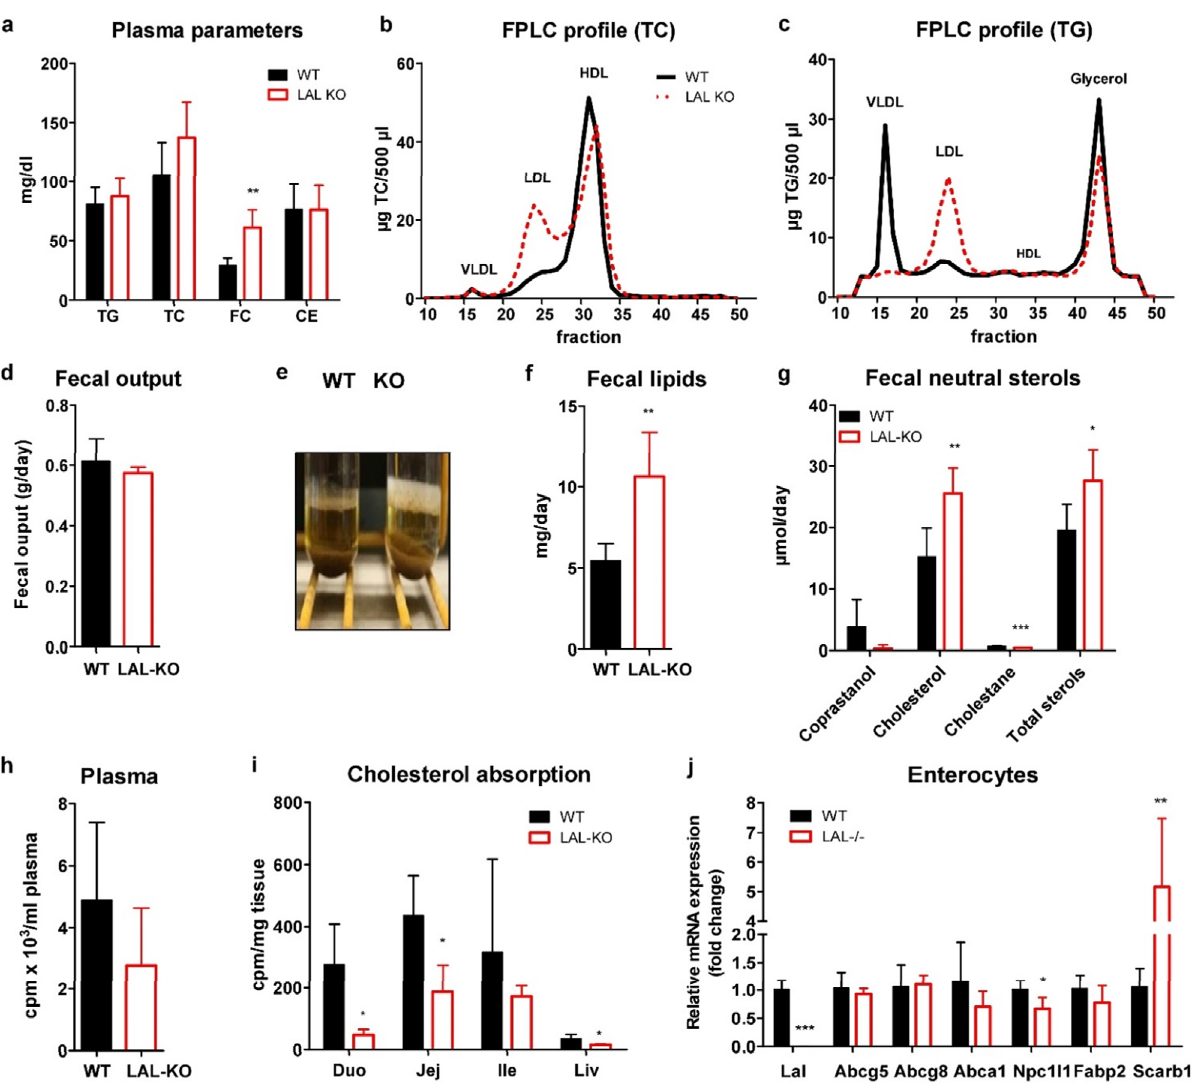
Figure 2. Impaired cholesterol absorption in LAL-KO mice: ( a ) Plasma lipid parameters and lipoprotein profiles of ( b ) TC and ( c ) TG concentrations after separation by fast performance liquid chromatography of pooled plasma from 12 h-fasted male mice (n = 6, 25 weeks old, 6 weeks on WTD). ( d ) Daily fecal output. ( e ) Feces of WTD-fed male mice (n = 6, 12–14 weeks old) were collected for 72 h. The picture shows the upper lipid layers in the extraction tubes of fecal samples. Quantification of ( f ) total fecal lipids and ( g ) fecal neutral sterols. ( h , i ) Cholesterol absorption was measured in chow diet-fed female mice (n = 4–5, 10 weeks old). After a 4 h-fasting period, mice were gavaged with 200 µL corn oil containing 2 µCi [ 3 H]cholesterol and 200 µg cholesterol. Radioactivity was measured 4 h post-gavage in ( h ) plasma and ( i ) isolated tissues by liquid scintillation counting. ( j ) Enterocyte mRNA expression of cholesterol transporters relative to Gapdh as reference gene (n = 5–6). Data represent means + SD; p < 0.05 (*), p ≤ 0.01 (**), p ≤ 0.001 (***). Student’s unpaired t-test.